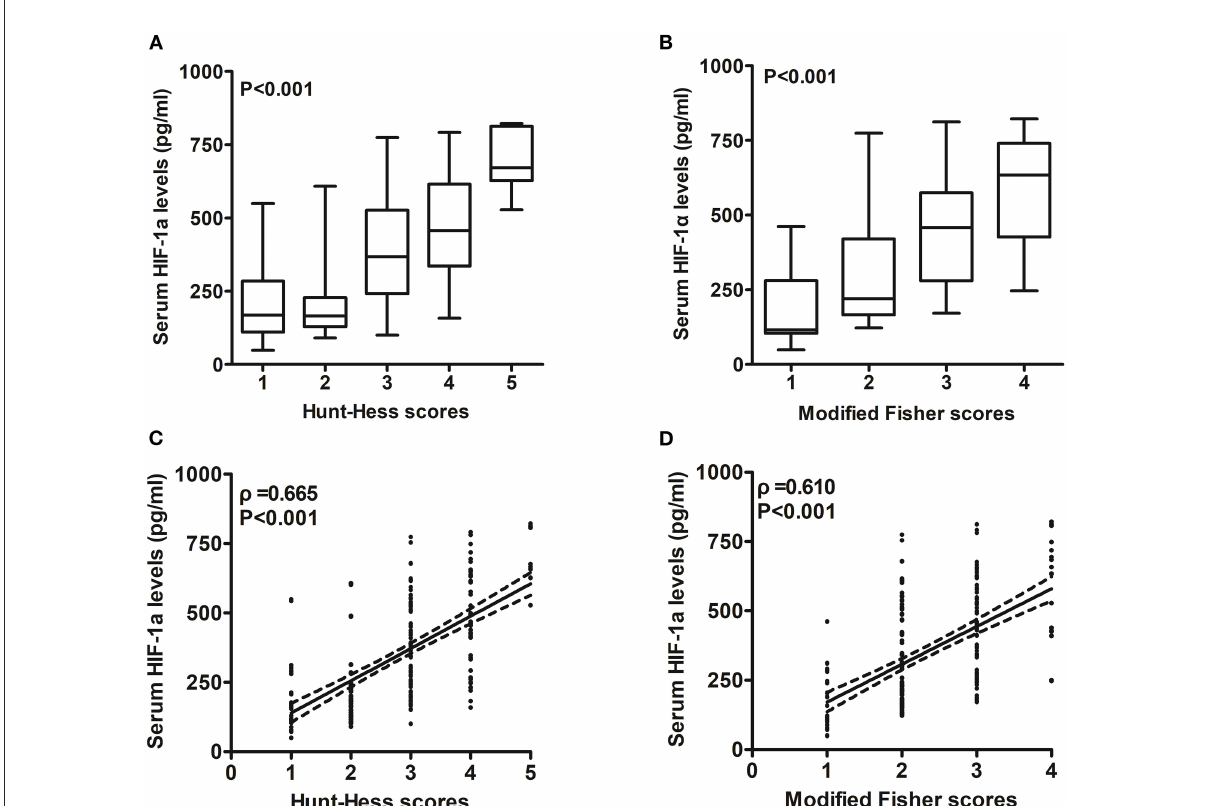
FIGURE3 Relationship between serum hypoxia-inducible factor 1alpha levels and illness severity after aneurysmal subarachnoid hemorrhage. (A) Serum hypoxia-inducible factor 1alpha levels among patients with different Hunt–Hess scores. Serum hypoxia-inducible factor 1alpha levels were substantially lowest in patients with Hunt–Hess score of 1, followed by Hunt–Hess scores of 2, 3, and 4, and were markedly highest in those with Hunt–Hess score of 5 ( P < 0.001). (B) Serum hypoxia-inducible factor 1alpha levels among patients with different modified Fisher scores. Serum hypoxia-inducible factor 1alpha levels were substantially lowest in patients with modified Fisher scores of 1, followed by modified Fisher scores of 2 and 3, and were markedly highest in those with modified Fisher scores of 4 ( P < 0.001). (C) Relation of serum hypoxia-inducible factor 1alpha levels to Hunt–Hess scores. Serum hypoxia-inducible factor 1alpha levels were substantially correlated with Hunt–Hess scores ( P < 0.001). (D) Relation of serum hypoxia-inducible factor 1alpha levels to modified Fisher scores. Serum hypoxia-inducible factor 1alpha levels were substantially correlated with modified Fisher scores ( P < 0.001). HIF-1 α means hypoxia-inducible factor